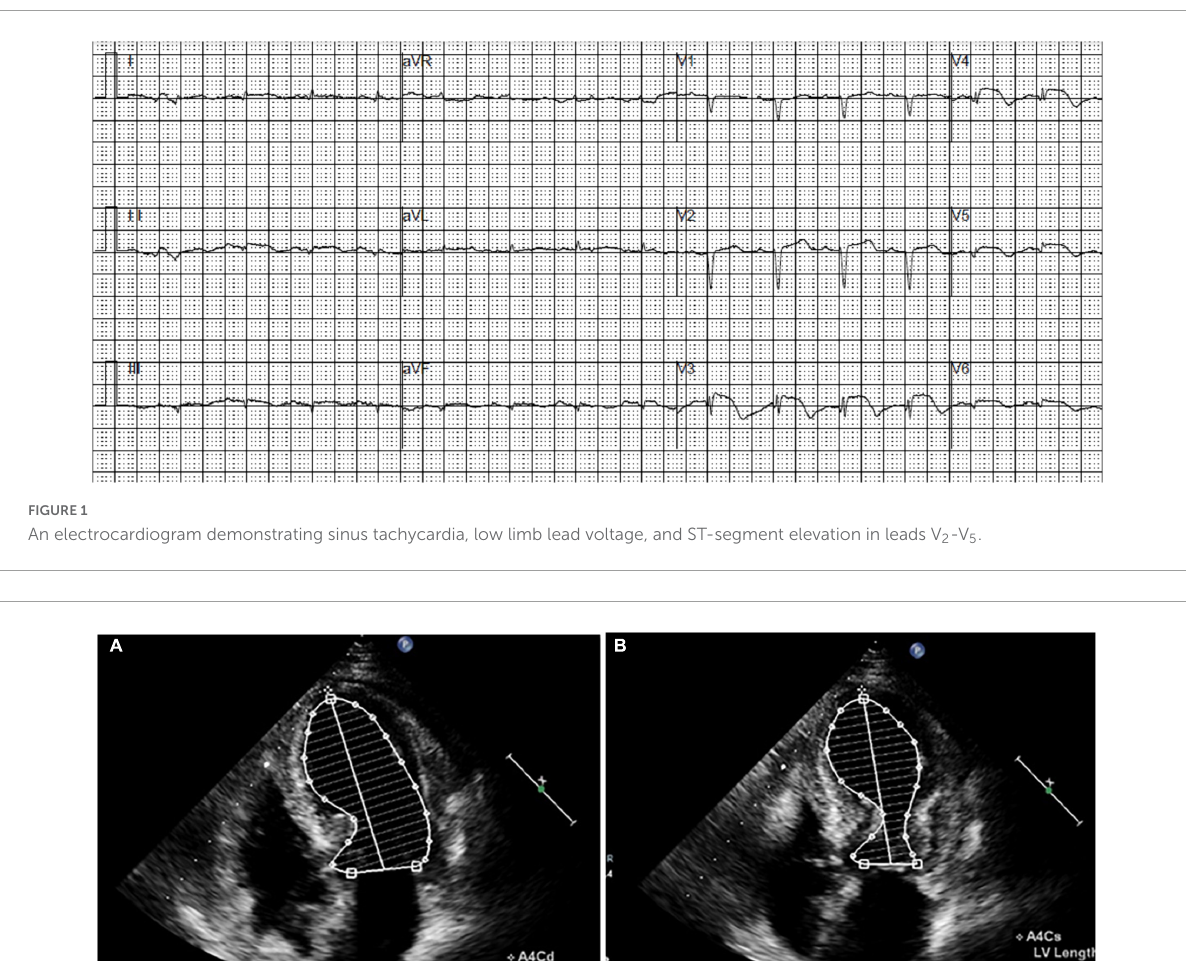
empagliflozin, and alogliptin. Empagliflozin has been indicated for both diabetes and heart failure in such cases.